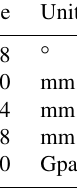
Table 1. Parameters of the fixed-guided beam. Parameter Value Unit